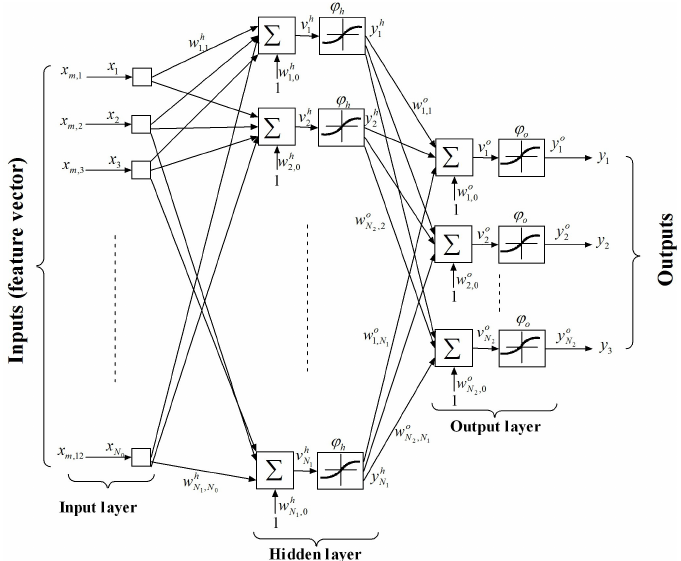
Figure 4. Example of multi-layer perception (MLP) network network having N 0 = 12 inputs, one hidden layer of N 1 neurons, and N 2 = 3